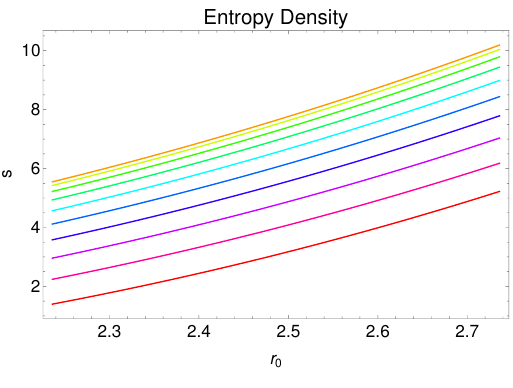
Figure 16 . Entropy of branes ending on the